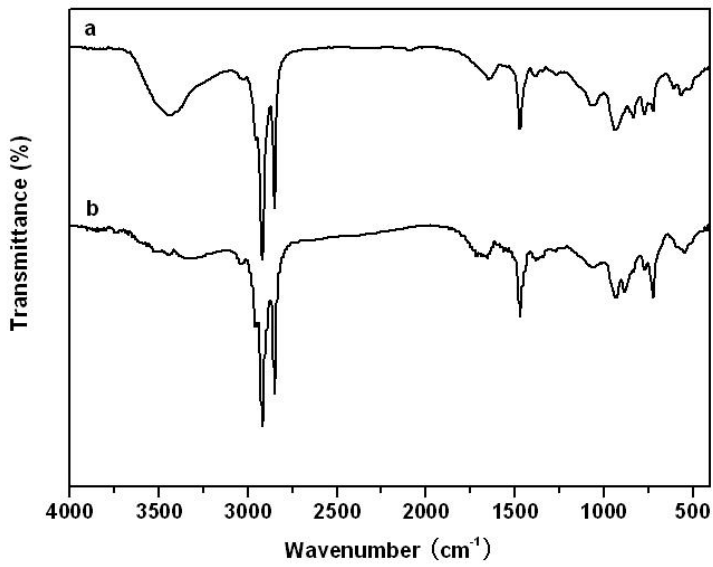
Figure 3. FT-IR spectra of the catalyst: ( a ) fresh catalyst, ( b ) used catalyst.